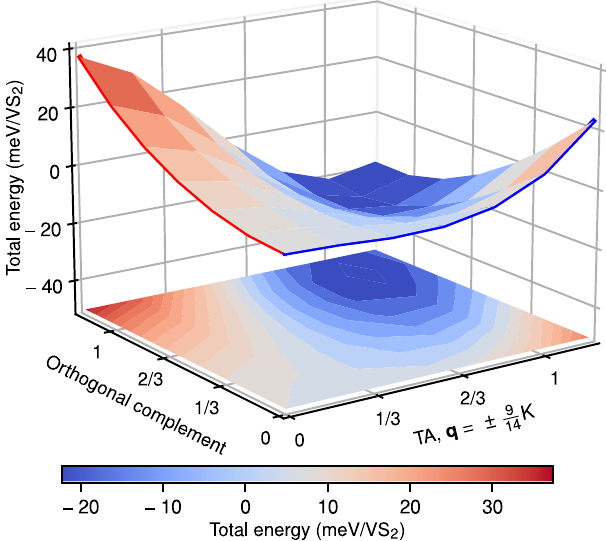
ffiffiffi p 3 R30 (cid:4) structure of